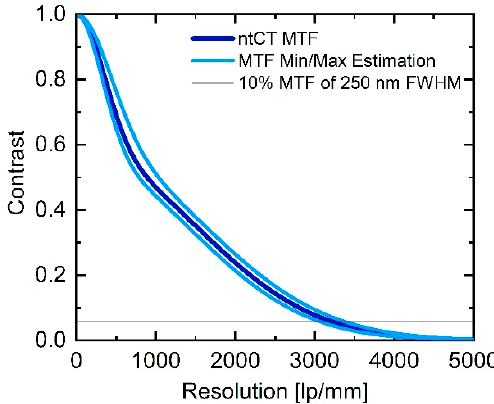
Figure 4. 2D MTF graph derived from the Siemens star image. As the electron spot in the source can be approximately described by the superposition of a narrow and a wide focal spot, the MTF is also composed of a high-frequency contribution (corresponding to 250 nm point spread FWHM) and a low-frequency background share (corresponding to 1.1 µm point spread FWHM) [31].